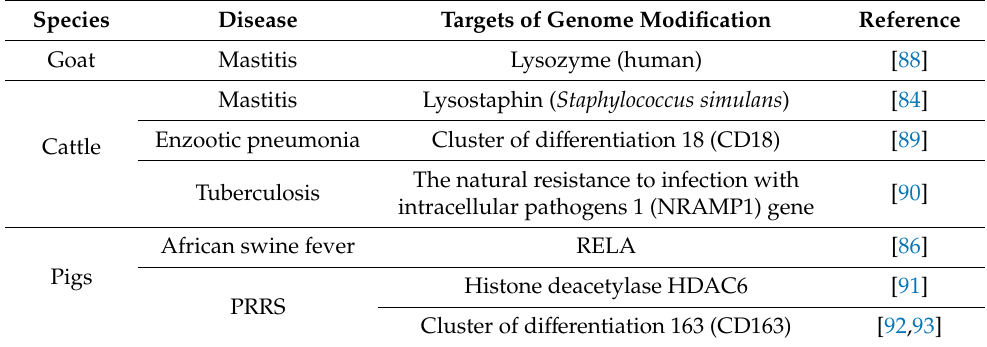
Table 2. Reported application of genome editing techniques for disease resistance livestock